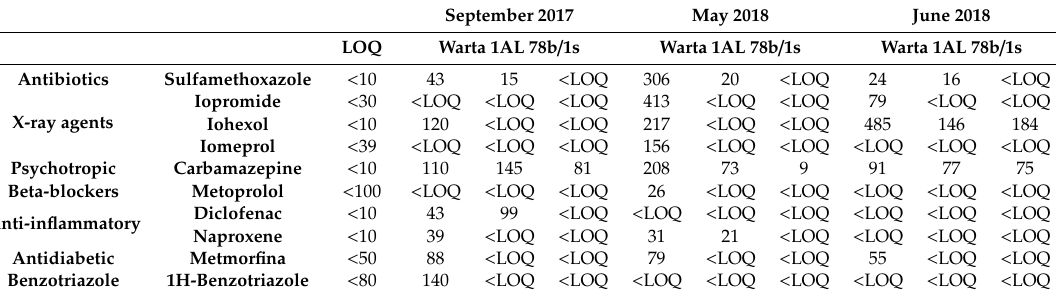
Table 3. Concentrations of pharmaceuticals in ng / L: The preliminary investigation. < LOQ - below limit of quantification. (Measurements performed in ALS Laboratory in